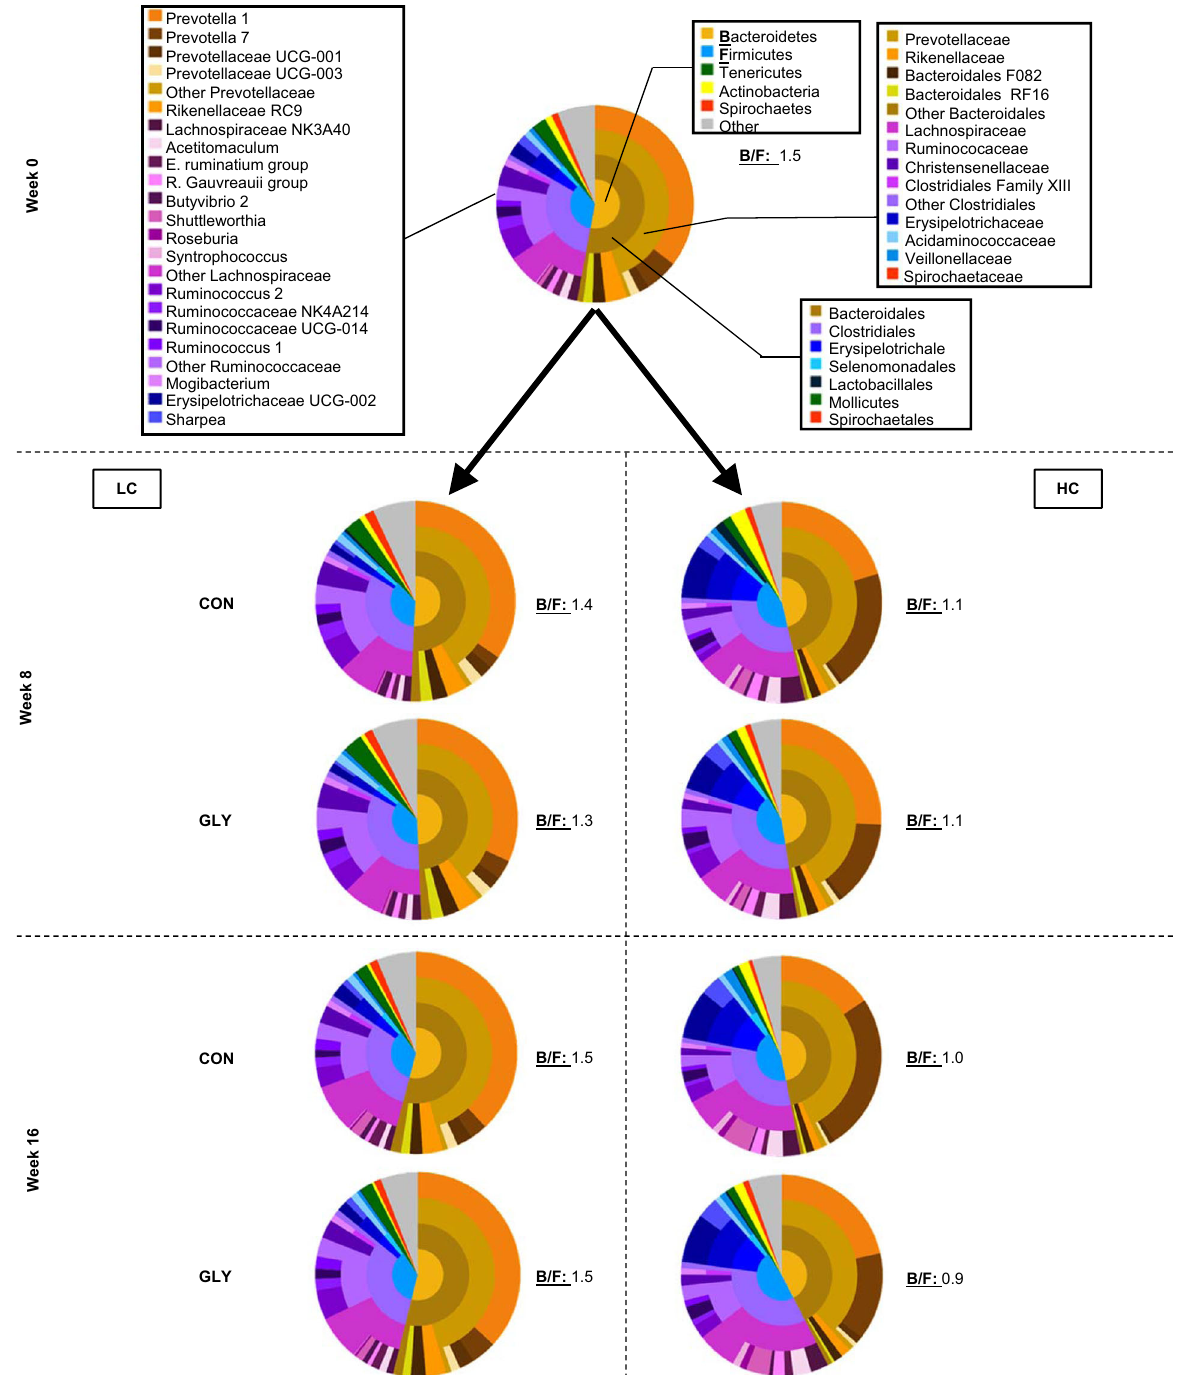
Fig. 4 Taxonomic composition of the ruminal microbiome in response to varying concentrate feed proportion and glyphosate. Depicted are donut plots with the taxonomic compositions of the ruminal microbiome in week 0 (merged for all animals in the trial) and in weeks 8 and 16 (merged for all animals within an experimental group). The inner circles represent the composition on phylum level, while the 2nd circles from the inside represent the composition on order level, the 3rd circles from the inside represent the composition on family level and the outer circles represent the genus level. Taxonomic assignments and corresponding colors for each circle are displayed in week 0. B/F resembles the ratio between the main phyla Bacteroidetes and Firmicutes . CON: groups fed with a control diet, GLY: groups fed with a glyphosate contaminated diet, CFP: concentrate feed proportion, HC: groups with a high CFP, LC: groups fed with a low CFP. The individual subplots including proportions of the taxonomic groups can be found as interactive.htm plots in Supplementary Data